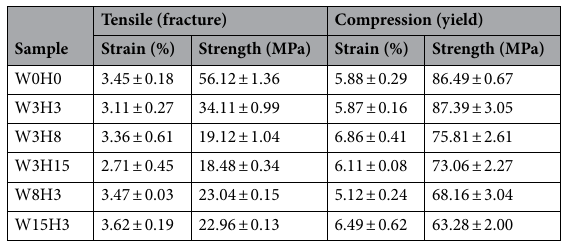
Table 3. Mechanical properties of the PLA/WS/HA composites after being immersed in deonized water for 6 weeks.